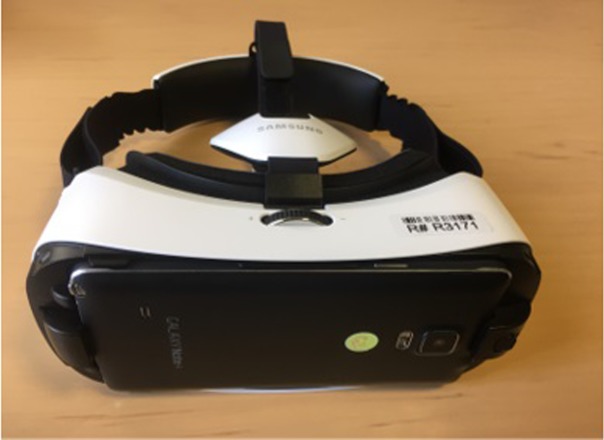
Samsung gear virtual realty headset.